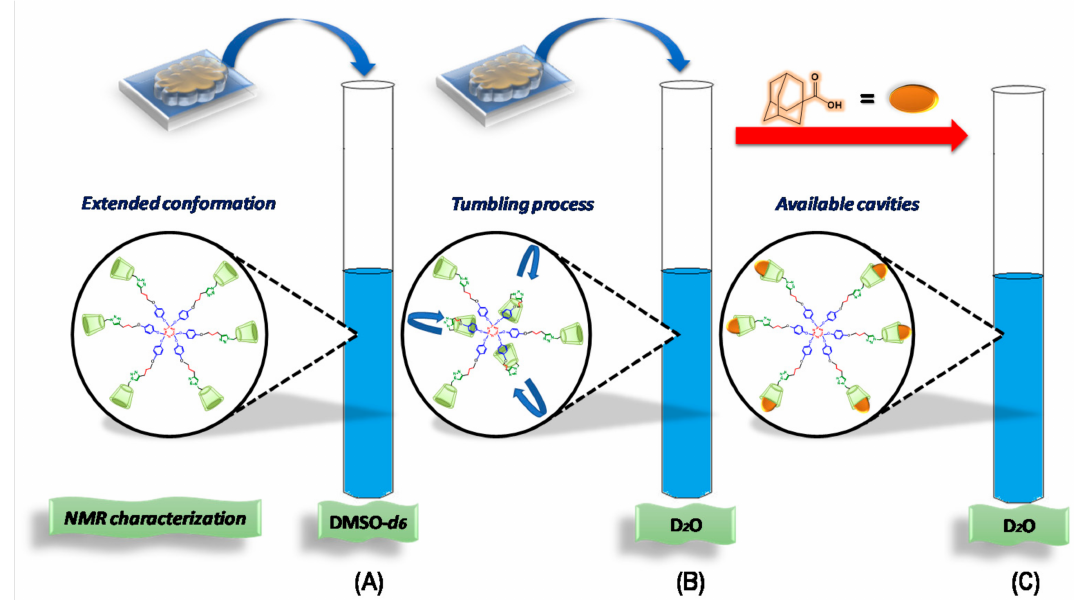
Figure 2. Possible scenarios for the characterization of P 3 N 3 -[O-C 6 H 4 -O-(CH 2 ) n - β CD] 6 ( n = 3 or 4) compounds by NMR, ( A ) Extended conformation, ( B ) Tumbling process and ( C ) Available cavities in in dendritic compounds ( I ) and ( II ).